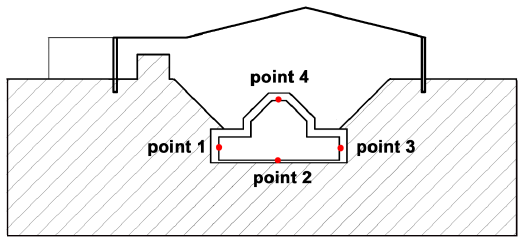
Figure 9. Four simulation points.